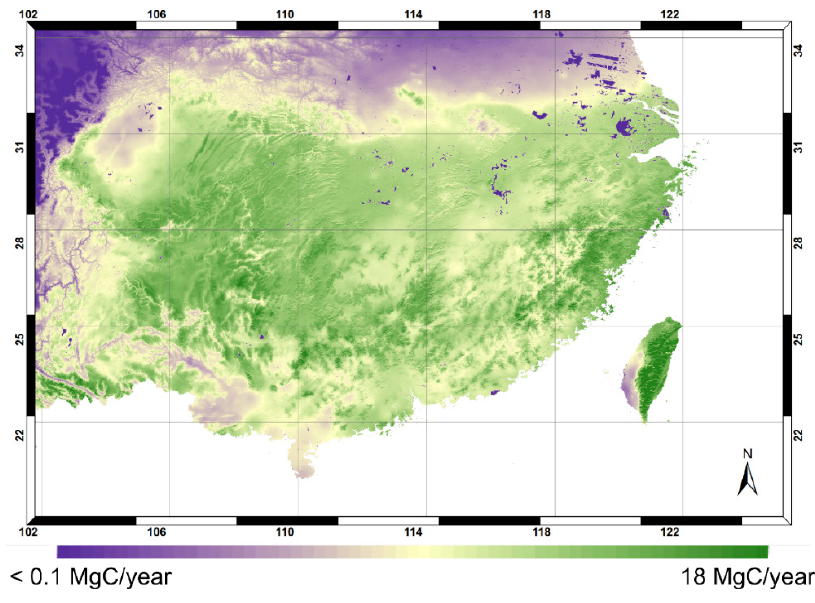
Figure 9. Total NPP (MgC/year) of Chinese fir under current climate.